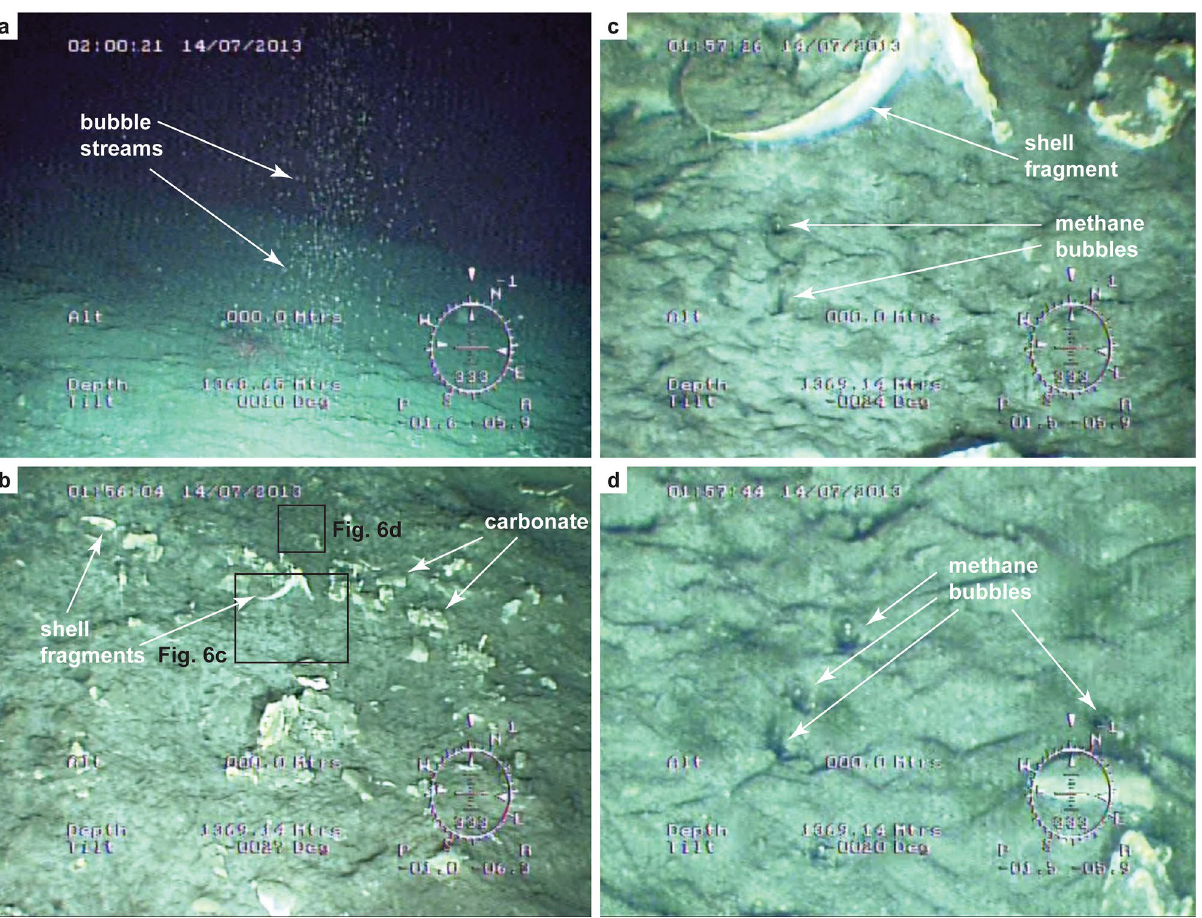
Figure 6. Seafloor photographs taken from a remotely operated vehicle (ROV) showing seafloor methane emission sites: ( a ) gas flare formed by a cluster of bubble streams (diameter of the cluster is ca. 1.5 m), ( b ) detail of the seafloor nearby flares with fragments of shells and carbonate concretions, ( c ) and ( d ) methane bubbles of ca. 0.5 cm in diameter venting from the seafloor (bubbling rate varies considerably among streams, from 0.5 to 7 bubbles per second or ca. 0.03–0.5 cm 3 s −1 of methane in each stream). The shell fragment identified in ( b ) and ( c ) is ca. 10 cm in diameter. The photos were taken in the gas flare in the pockmark near the PC83 piston core (see Fig. 4a for location and Supplementary Videos 1 and 2 for a more complete documentation of the